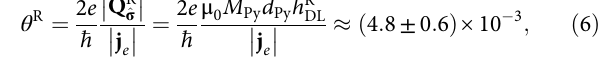
its spatial distribution is fi tted with the Biot – Savart law 26 .